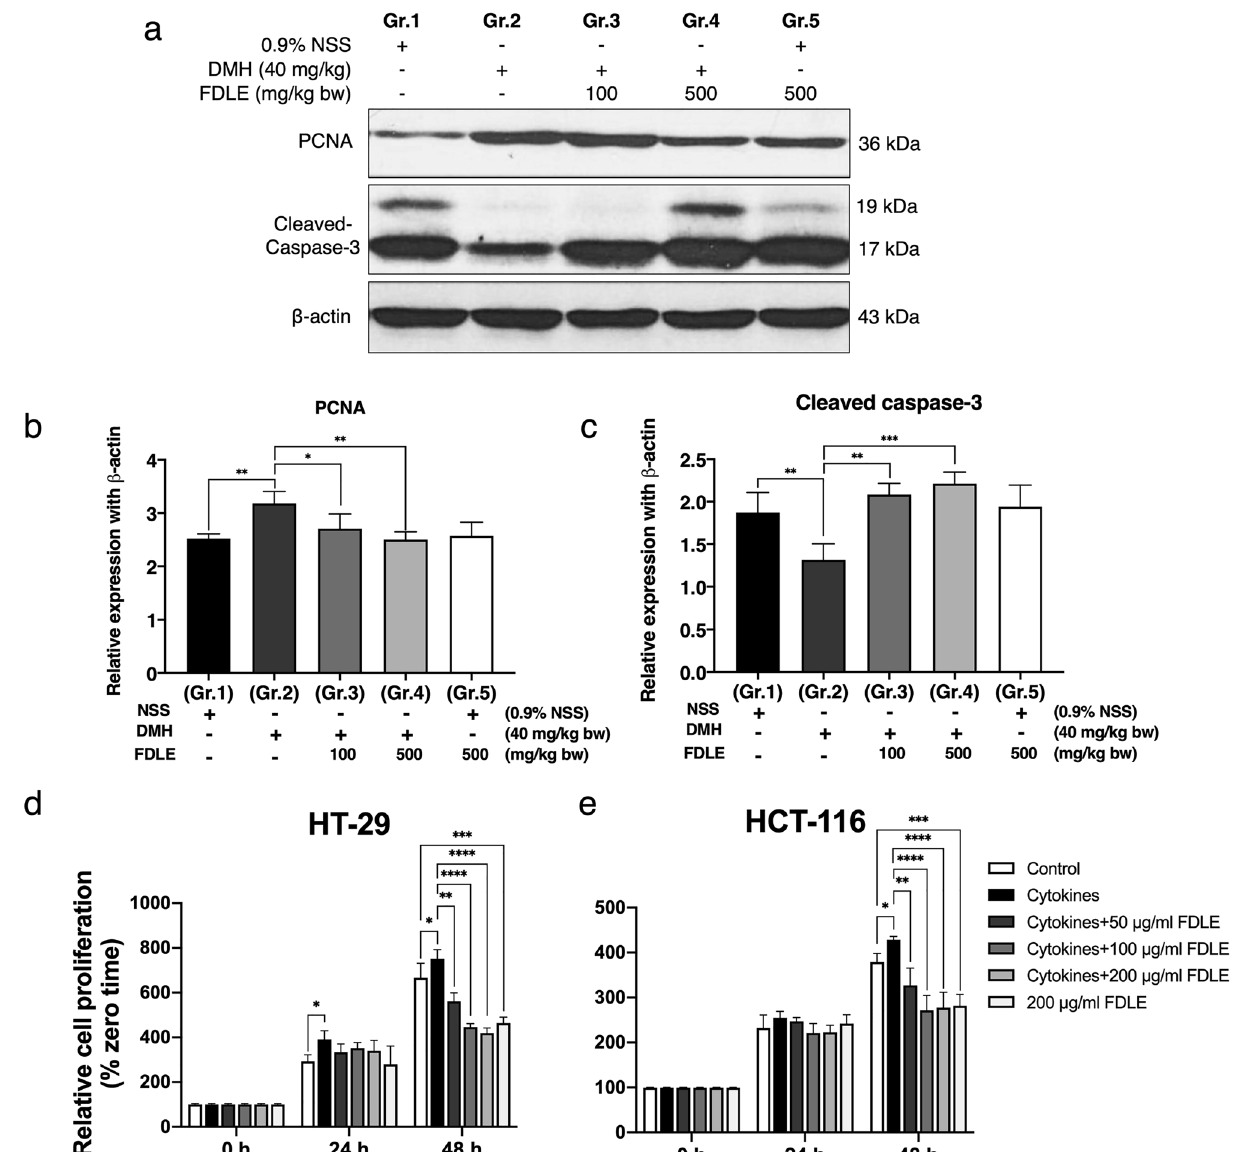
Figure 5. Effect of FDLE on cell proliferation and apoptosis in rat colonic mucosa and human colorectal cancer cells. ( a ) Immunoblot analysis of PCNA, cleaved caspase-3 and β-actin proteins. ( b ) Relative expression of PCNA to β-actin proteins. ( c ) Relative expression of cleaved caspase-3 to β-actin protein. Data are presented as the mean ± SD of four rats per group. Relative cell proliferation (%zerotime) of colorectal cancer cell lines with cytokines (TNF-α, IFN-γ and LPS each 10 ng/mL) or together with FDLE for 24 and 48 h. ( d ) HT-29 cells. ( e ) HCT-116 cells. Data are presented as the mean ± SD of three independent experiments with similar results, *p < 0.05, **p < 0.01, ***p < 0.001, ****p < Effects of FDLE on cell proliferation of HT‑29 and HCT‑116 colorectal cancer cell lines induced by pro‑inflammatory cytokines. To investigate the effect of FDLE on the growth of the HT-29 and HCT- 116 colorectal cancer cell lines in an inflammatory environment, we examined FDLE’s anti-proliferation activity against cytokine-induced HT-29 and HCT-116. As shown in Fig. 5d,e, treatment with cytokines resulted in a considerable increase in the relative cell number of HT-29 and HCT-116 at 48 h, when compared to the nega- tive control. After 48 h, FDLE administration considerably decreased cytokine-induced HT-29 and HCT-116 cell proliferation, compared to the positive control; at the same time, a high dose of FDLE administration dra- matically decreased cytokine-induced HT-29 and HCT-116 cell proliferation, compared to the negative control. Cytokines were found to enhance cell proliferation, whereas FDLE inhibited cell proliferation in both inflamed and non-inflamed HT-29 and HCT-116 colorectal cancer cell lines.